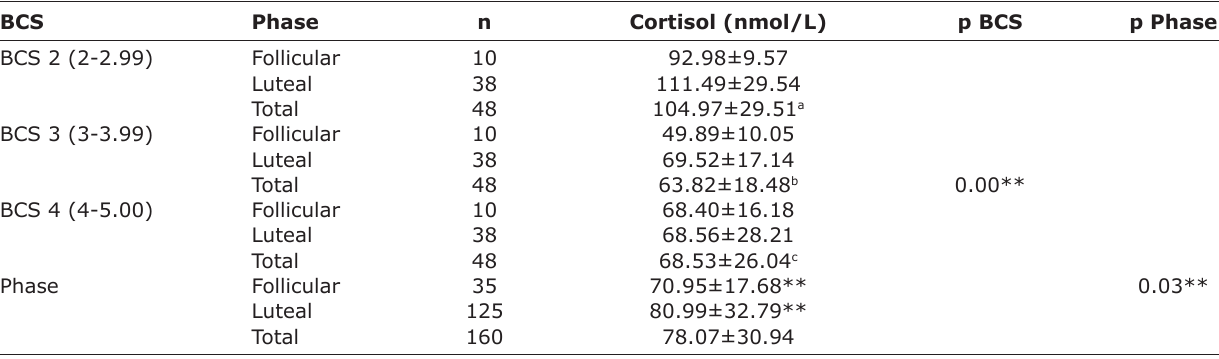
Table-5: Cortisol levels of Saanen goats in each body condition score during the phases of estrous cycle (mean±SD).